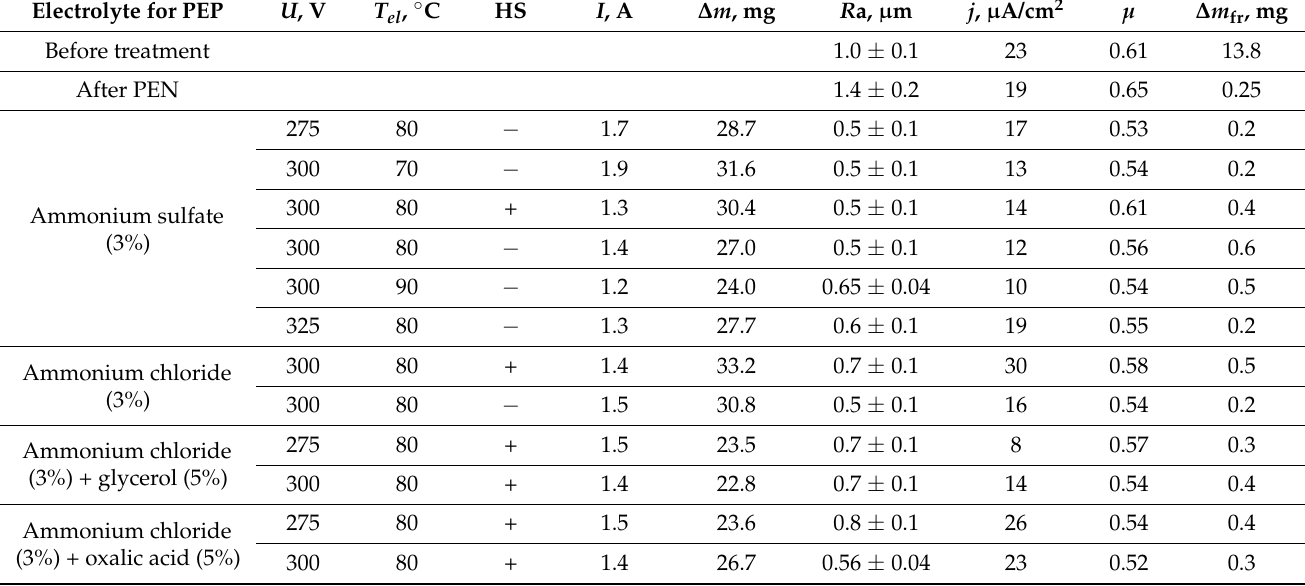
Table 1. Average current I , weight loss of samples ∆ m, surface roughness R a, corrosion current density j , friction coefficient µ and weight wear ∆ m fr before and after PEN with subsequent PEP in various electrolytes, at different voltages U and electrolyte temperatures T el . The signs indicate the applied hydrodynamic scheme (HS): forced circulation (+) or natural convection ( − ) of electrolyte. The PEP processing time is 1 min.